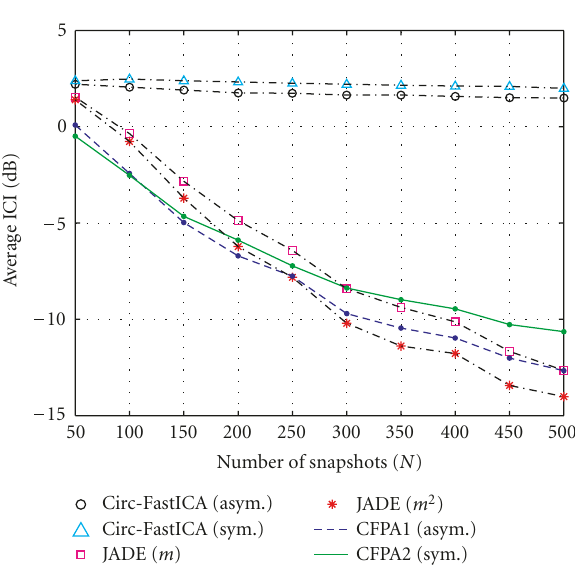
Figure 2: Average ICI as a function of data-record length N for the various algorithms on a more-challenging noiseless ten-source demixing task.